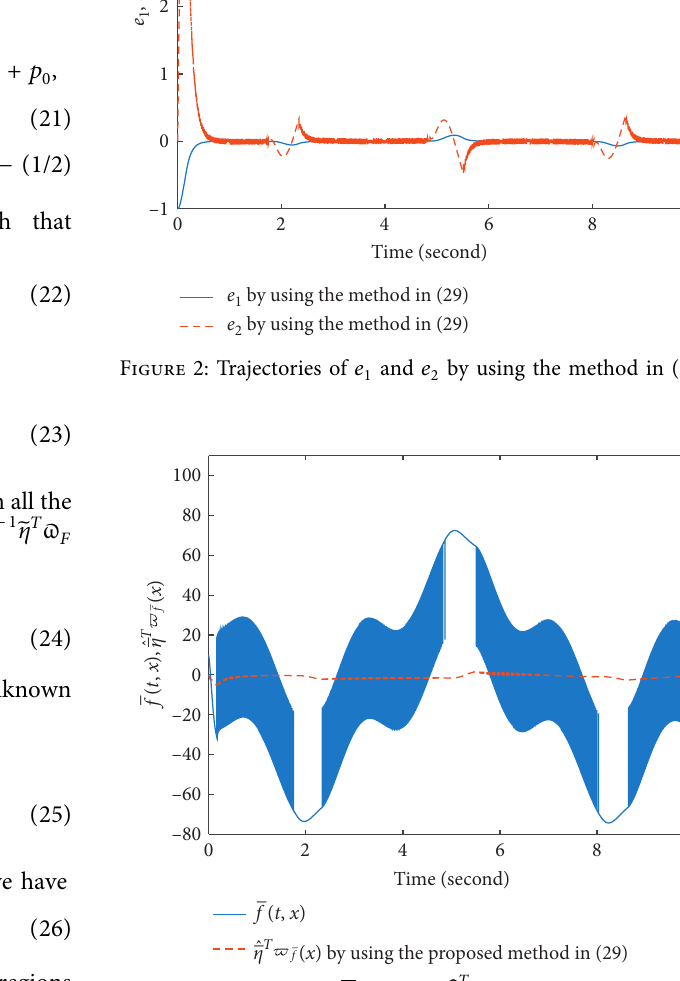
( x ) by using the method f